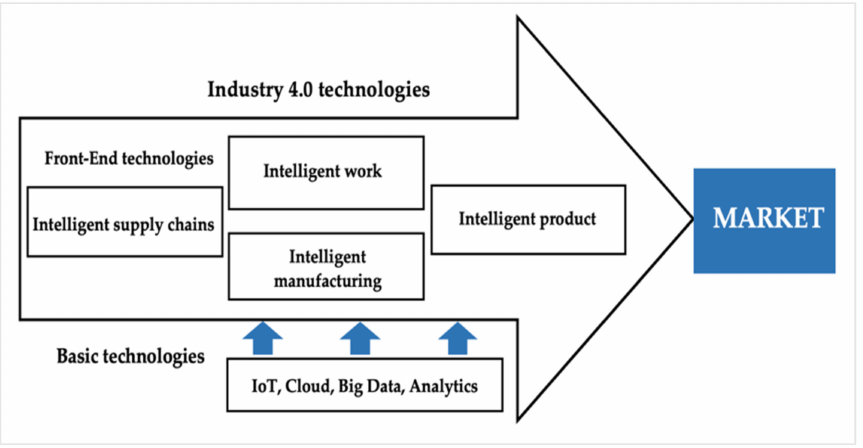
Figure 2. Scheme of Industry 4.0 technologies. Source: Authors’